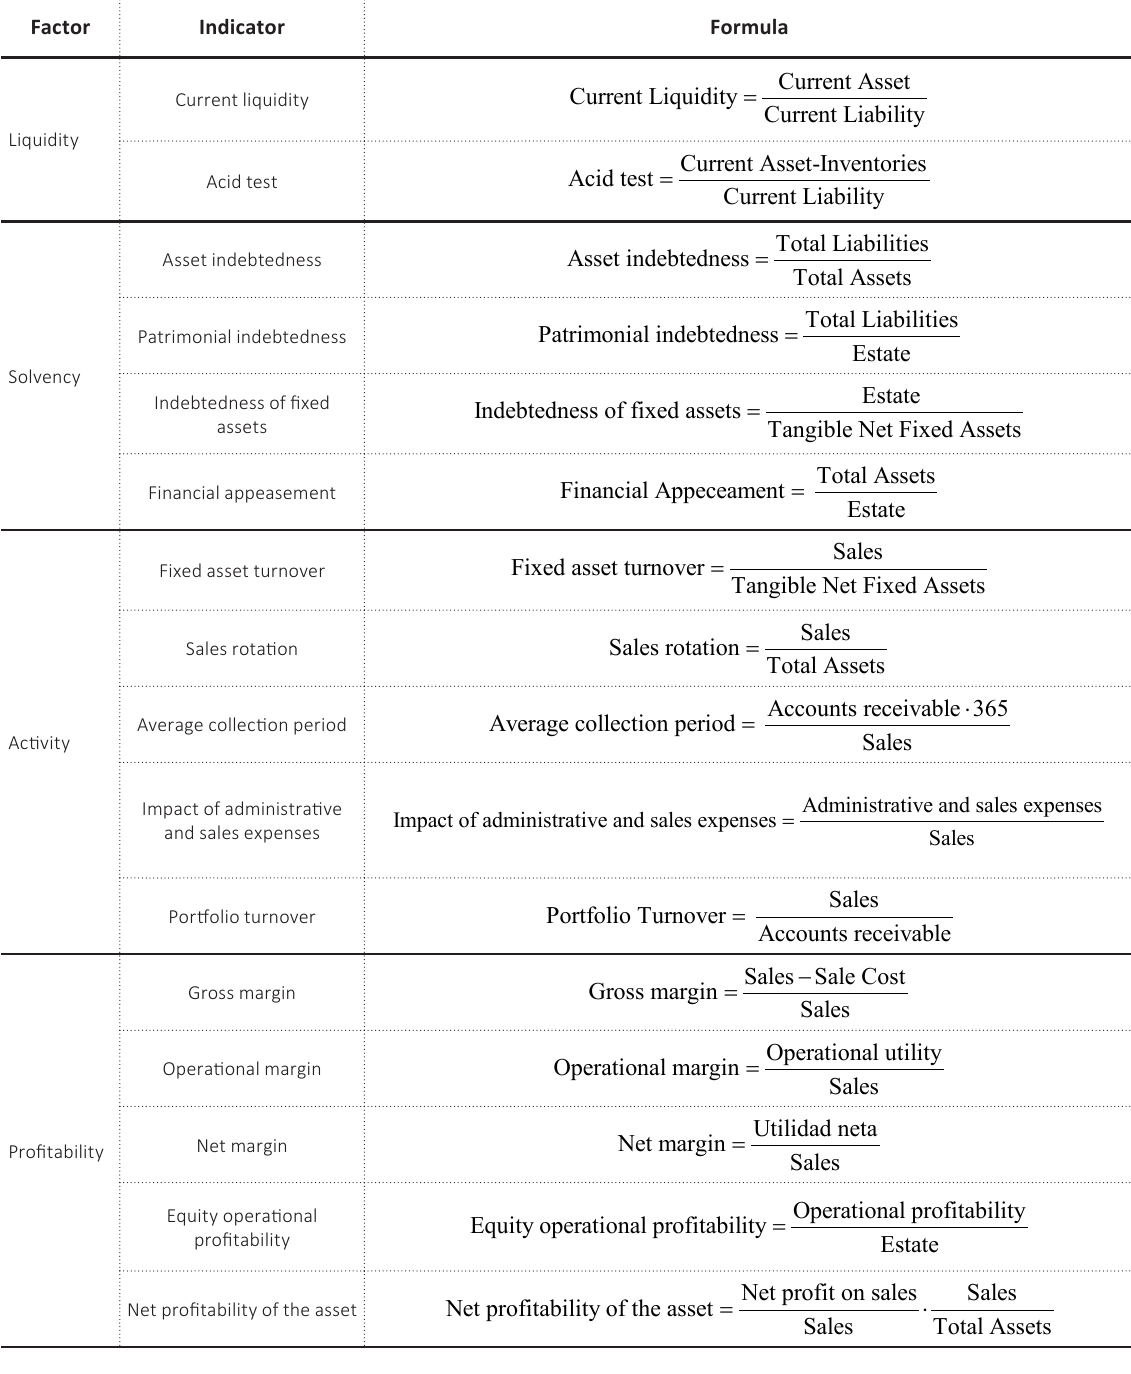
Table 2. Financial development